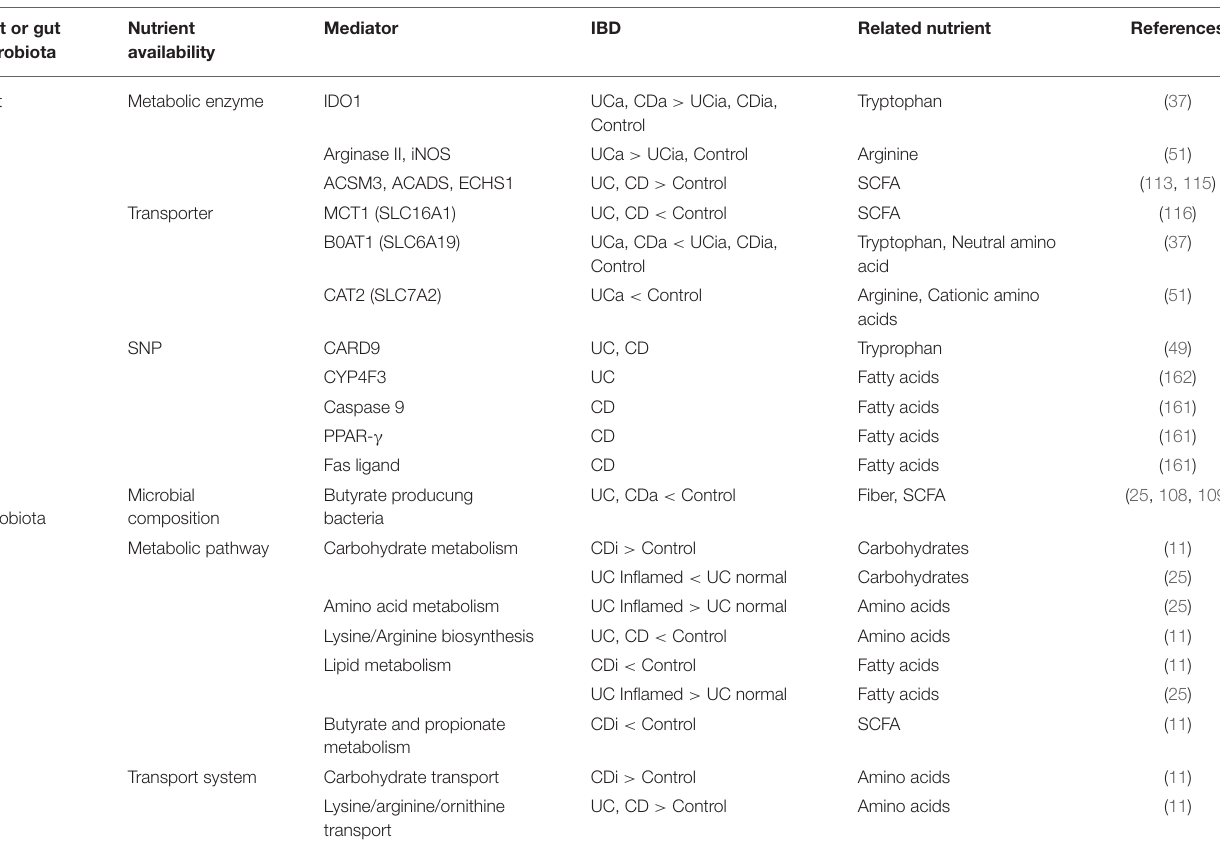
TABLE 2 | Changes of dietary nutrient availavility in the host and gut microbiota of